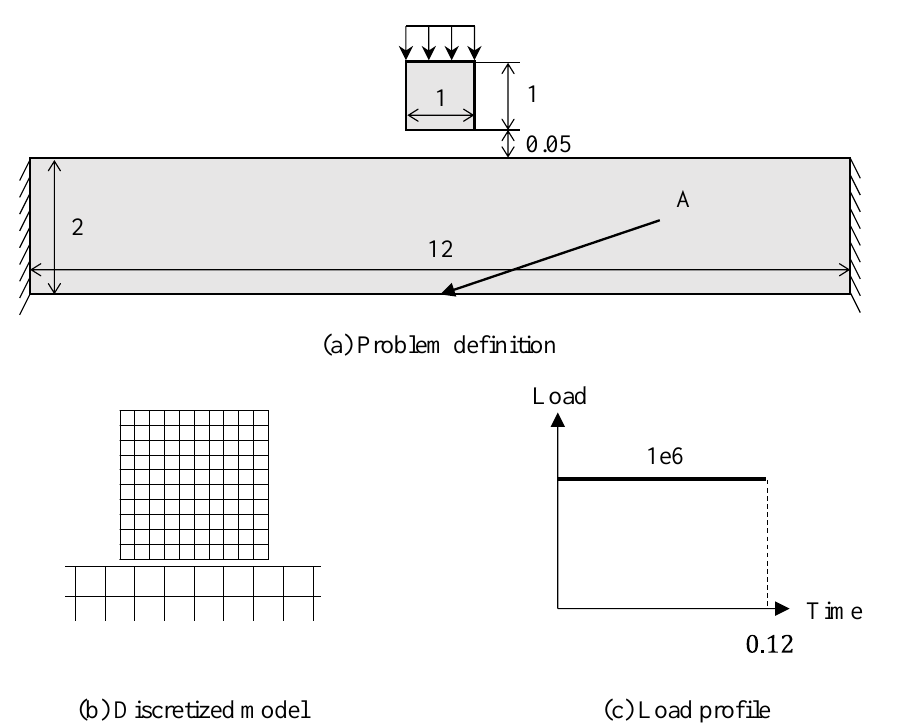
Figure 10. Problem definition of beam with a flying block.